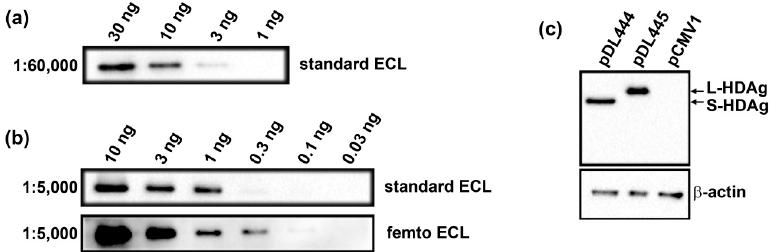
Figure 3. Detection of hepatitis delta virus (HDV) antigens using Western blotting with polyclonal rabbit sera specific to S-HDAg. ( a , b ) Detection of the recombinant S-HDAg in the amounts of 30 to 0.3 ng using rabbit serum #100-3a diluted as 1:60,000 ( a ) or 1:5000 ( b ) by the standard ECL, or sensitive femto ECL reagents (S-HDAg amounts are shown above the lanes in panels a and b ); ( c ) Expression of small and large HDV antigens in Huh7.5 cells. In brief, Huh7.5 cells were transfected with pDL444 or pDL445, respectively, and control cells, with empty vector pCMV1 (plasmid used is depicted on top of each lane) and grown for additional 48 h. Blots were first stained with anti-S-HDAg serum diluted at 1:5000 ( c , upper panel), then stripped and re-stained with mouse monoclonal against actin ( c , lower panel).